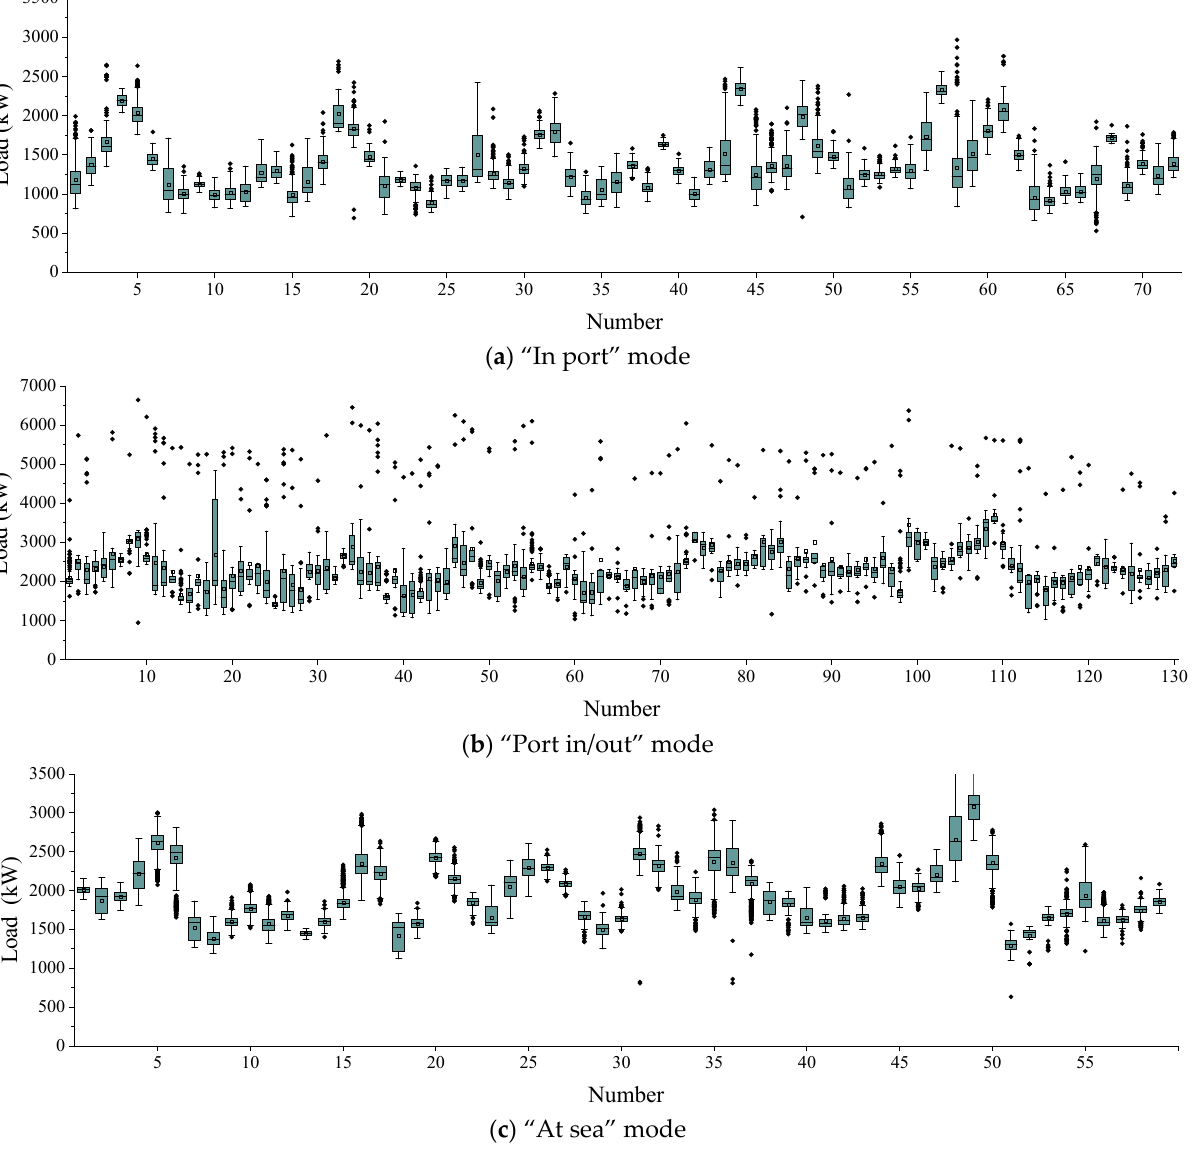
Figure 4. Box plot of electric load consumption in each